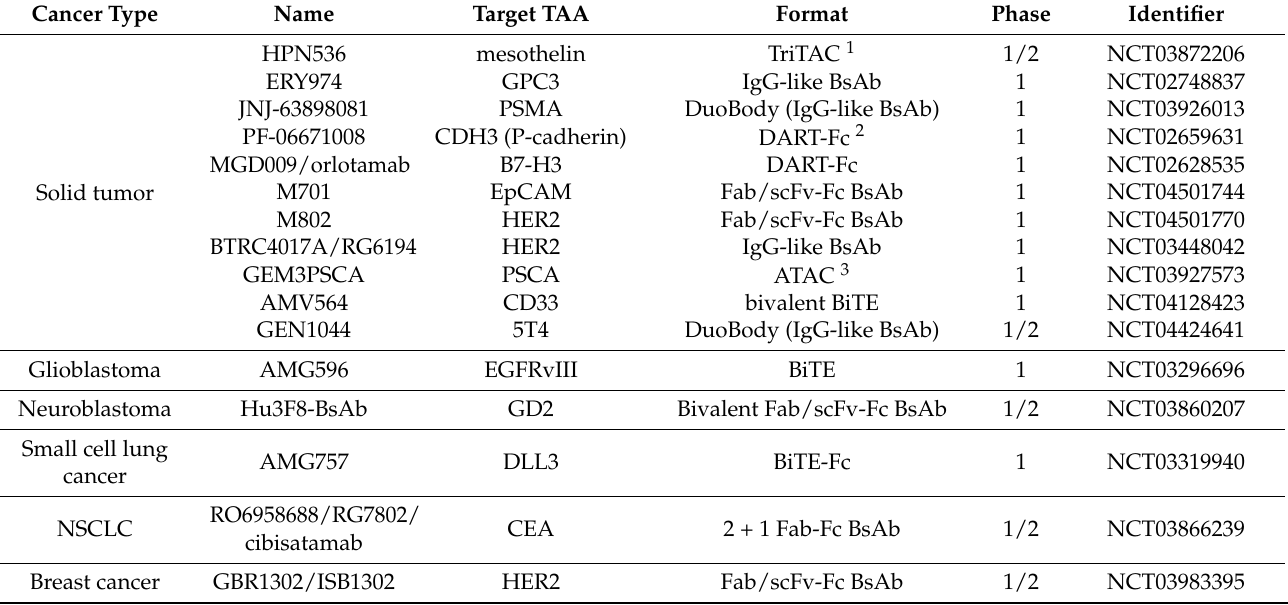
Table 2. T-BsAbs under clinical development for solid cancer treatment. More than 30 T-BsAbs have been investigated as monotherapies in clinical trials worldwide, most in the early phase. A variety of formats and target TAAs are being explored. Data are derived from ClinicalTrials.gov (accessed on 13 November 2021) and identifiers are shown in the